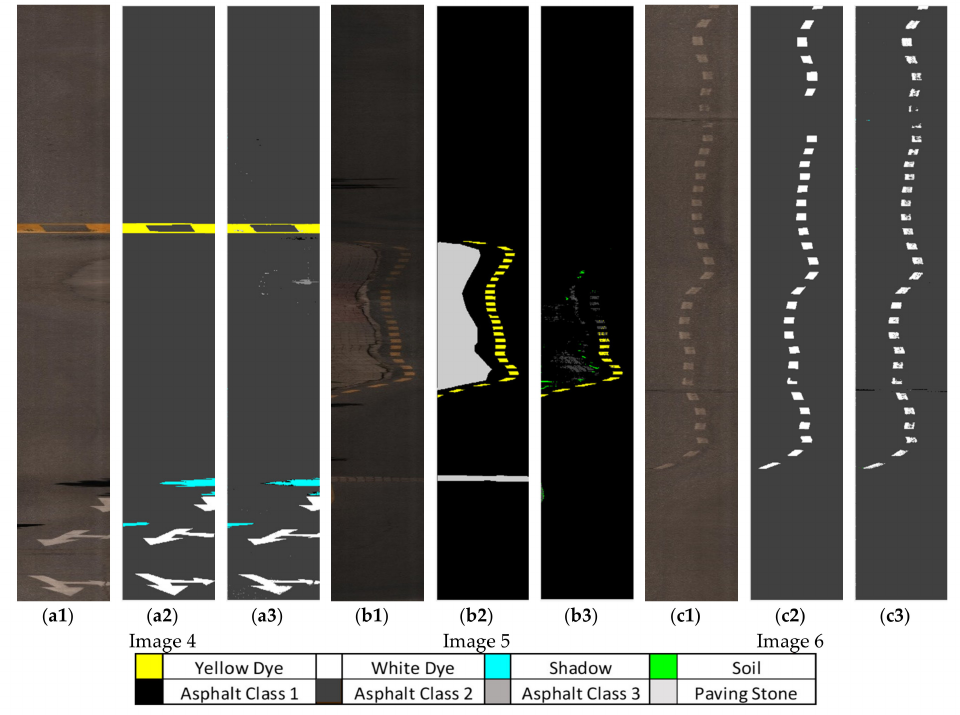
Figure 14. ( a1,b1 , c1 ) RGB image; ( a2 , b2,c2 ) ground truth; ( a3 , b3 , c3 ) algorithm outputs of the proposed methodology on the second set of